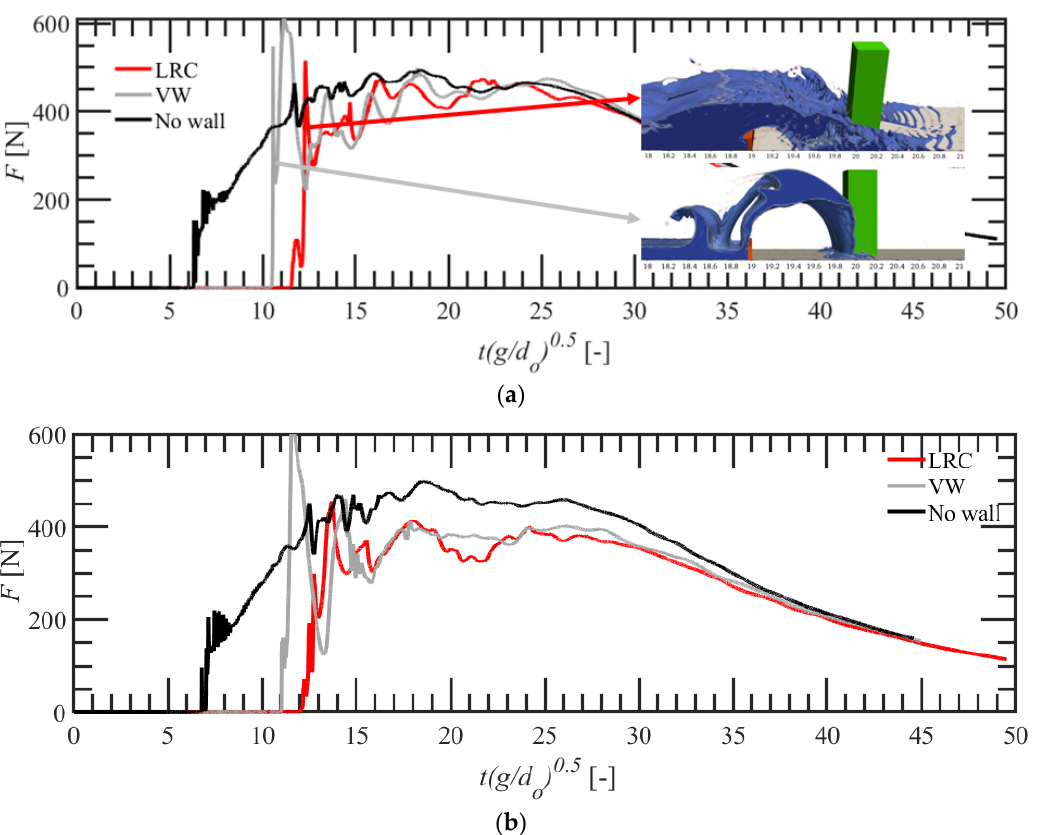
Figure 13. The combined effect of h s /h m and L on the forces on the inland structure for Wall 1: ( d o = 0.9 m); ( a ) L = 1 m; and ( b ) L = 2